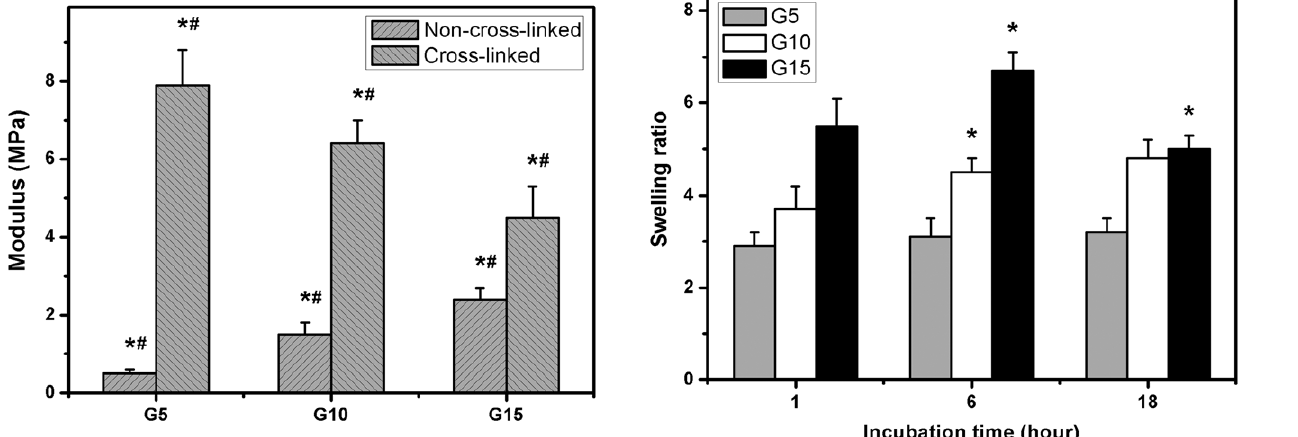
Figure 3. Mechanical tests. Young’s modulus of various gelatin samples. An asterisk indicates statistically significant differences (* P , 0.05; n =10) between the non-cross-linked and cross-linked groups for each type of gelatin sample. # P , 0.05 versus all groups (compared only within non-cross-linked or cross-linked groups).